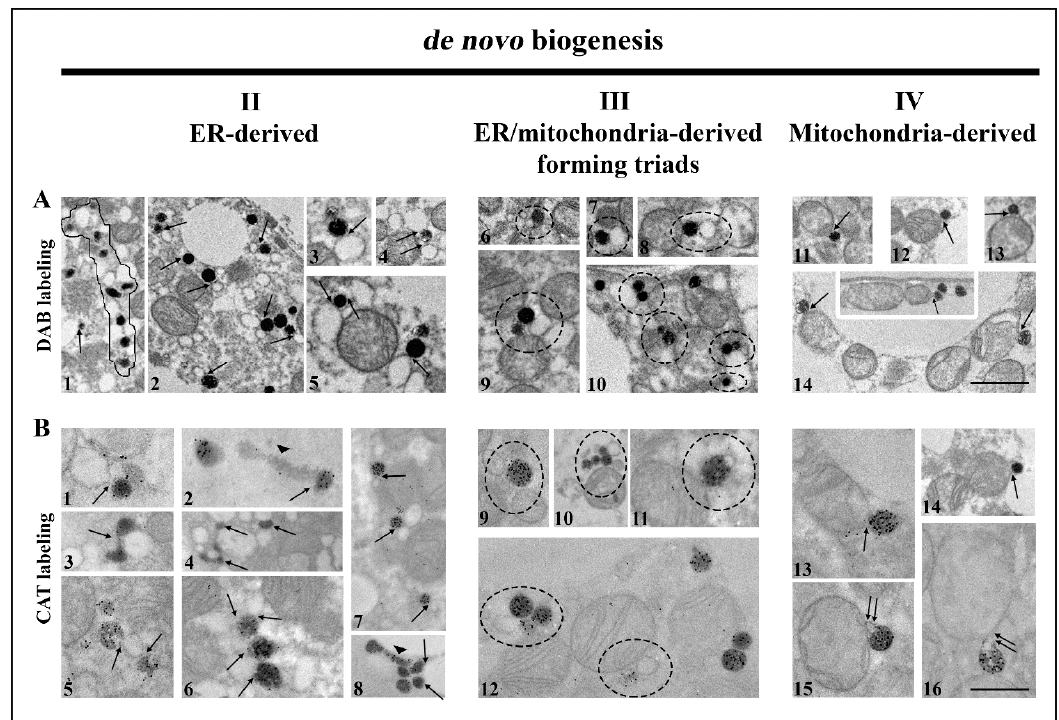
Figure 4. Ways of de novo peroxisomal biogenesis in brown adipocytes. Representative images from both euthyroid and hypothyroid groups with DAB-labelled ( A ) and CAT-labelled ( B ) peroxisomes. ER-derived peroxisomes ( A 1–5, B 1–8) are still connected with ER cisterns (arrows), by membranous bridges that connect these two organelles ( A 2–5, and B 1,5—arrows). Note the long pre-peroxisomal cisterns of ER ( B 2,8—arrowhead), but also structure-like “pearls on a string” ( A 1—outlined structure). ER/mitochondria-derived peroxisomes are also connected to ER and mitochondria at the same time, making triads of organelles ( A 6–10, B 9–12—circles). Triads in brown adipocytes suggest a hybrid nature of newly born peroxisomes. Mitochondria-derived peroxisomes ( A 11–14, B 13–16) are also connected to mitochondria via membranous bridges (arrows), suggesting that peroxisomes could originate from mitochondria in brown adipocytes. Original magnification 17,000 × ( A ), and 22,000 × ( B ). Scale bars 1 µ m.